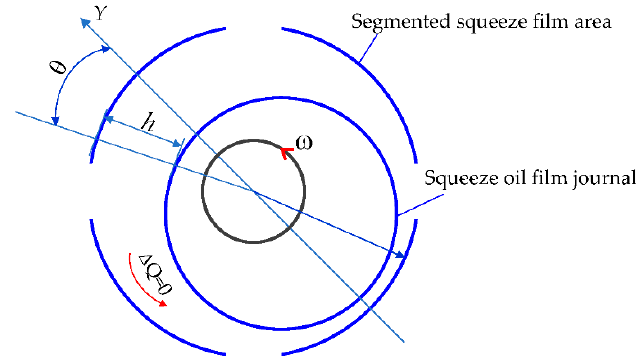
Figure 3. Damping vibration absorption model.